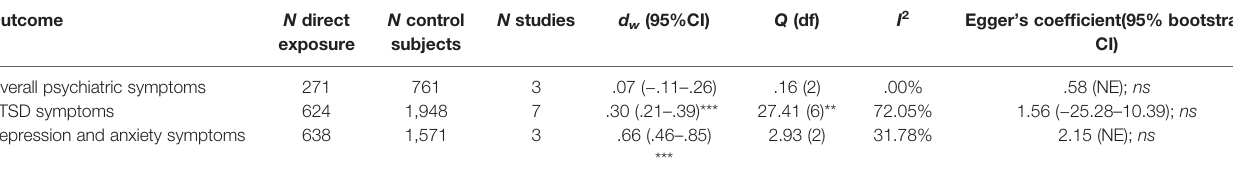
TABLE 3 | Pooled effect sizes concerning the effects of direct exposure to pandemic emergency. Outcome N direct